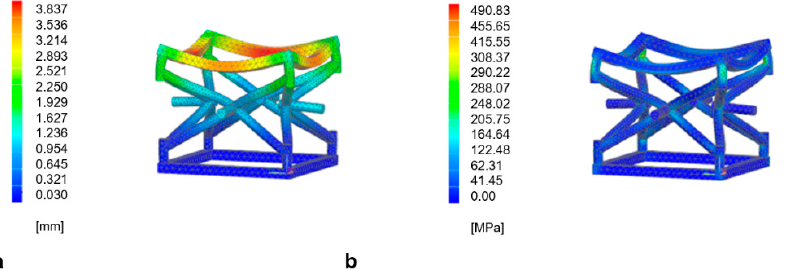
Figure 9. Overall deformation ( a ) and stress distribution ( b ) of the meta-functional auxetic unit cell under compression at the highest critical buckling load.